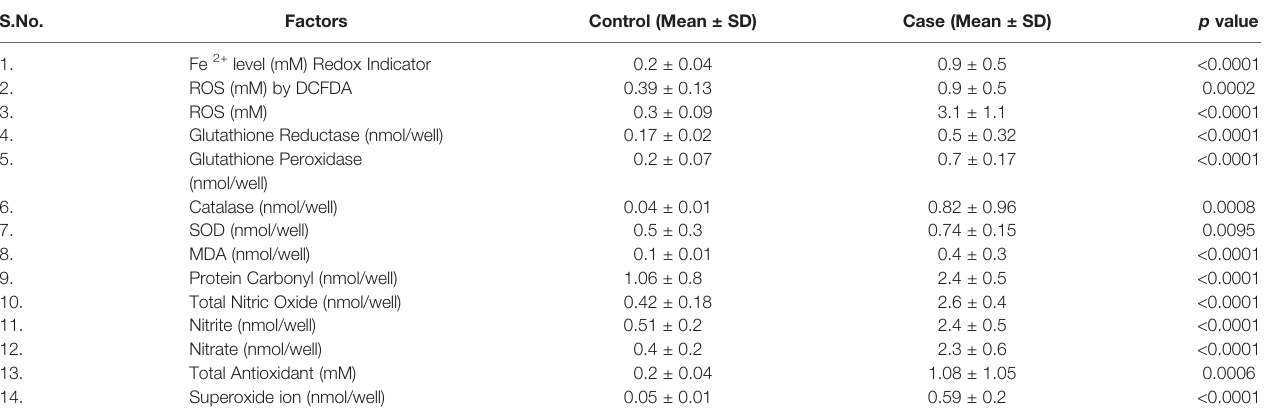
TABLE 2 | Quantitative details of oxidative and antioxidative parameters.